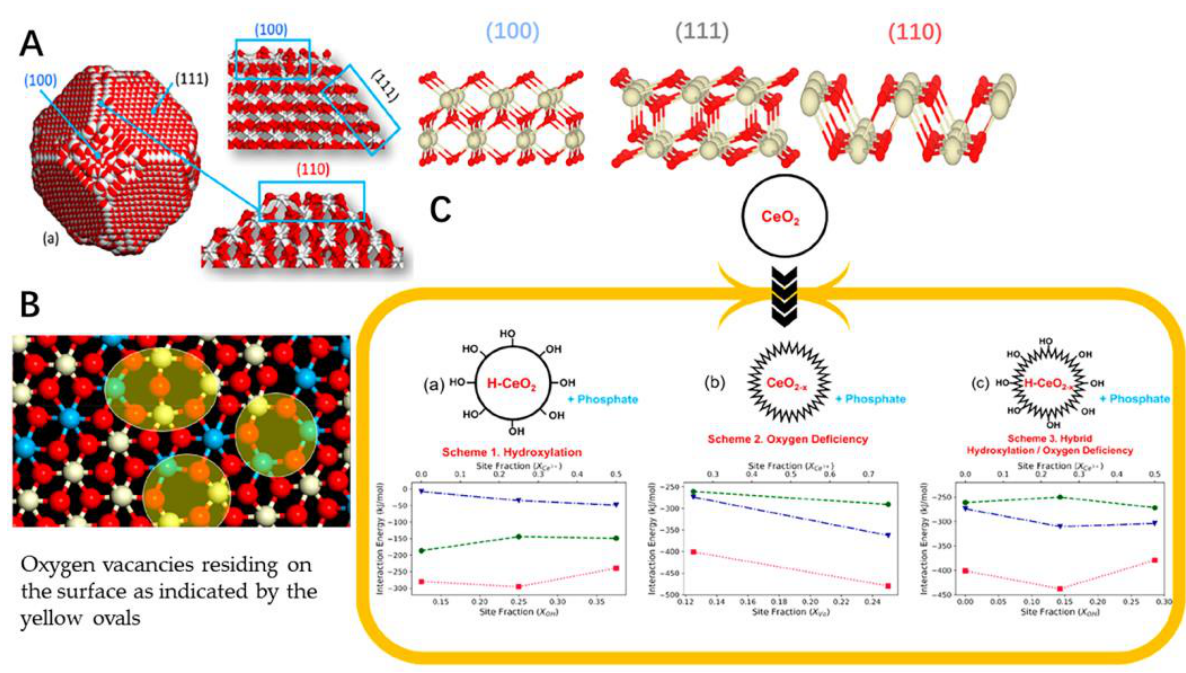
Figure 2. ( A ) Structure of a nanoparticle of ceria showing 111, 110 and 100 surfaces. The structures of “perfect” 111, 110 and 100 surfaces of nanoceria simulated using DFT are consistent with the structures of the surfaces exposed by the nanoparticle. ( B ) One of the nanoparticle’s 111 surfaces after nanoceria has been reduced. Ce 4+ is in white, Ce 3+ is in blue and oxygen is red. ( C ) Interaction energy of phosphate with nanoceria for three compositions of nanoceria in a living cell. Interaction energy (kJ/mol) of phosphate at nanoceria surfaces 111 (blue triangles), 110 (green circles) and 100 (red squares).